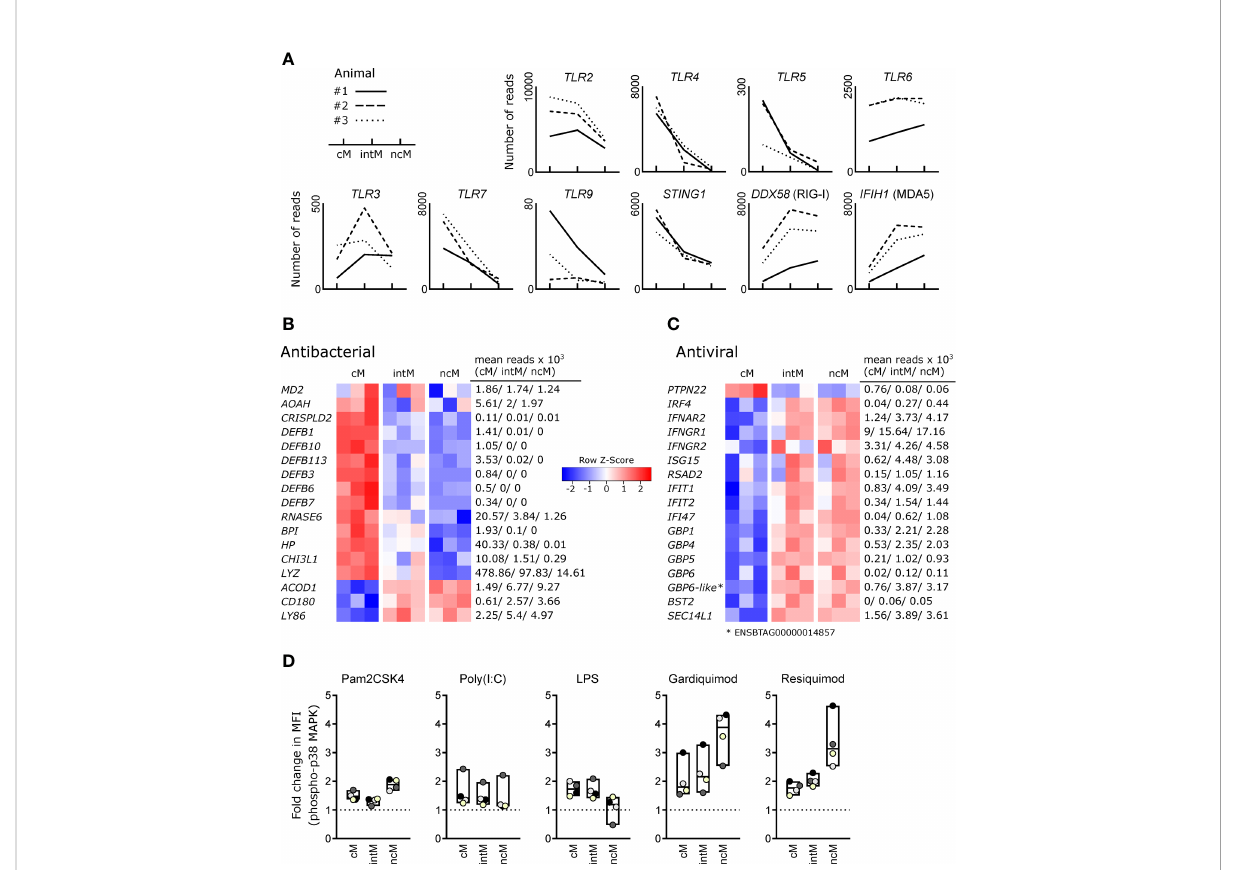
FIGURE 3 Antimicrobial gene expression and TLR responsiveness. Illumina sequencing was performed on RNA isolated from sorted monocyte subsets (cM, intM, ncM) of three animals. (A) Gene expression for pattern-recognition receptors. Graphs show the number of reads across monocyte subsets for selected genes with individual animals indicated by solid (#1), dashed (#2) and dotted (#3) lines. (B, C) Heatmaps show row z-scores calculated from log2-transformed normalized counts for genes associated with antibacterial (B) and antiviral (C) responses. Mean kilo reads for each subset and gene are given to the right of each heatmap. Genes were selected based on pairwise comparisons with DESeq2 (adjusted p- value < 0.05) and literature research. (D) Responsiveness of bovine monocyte subsets to TLR ligands. Defrosted bovine PBMC were depleted of CD3 + cells, stained for CD172a, CD14 and CD16, and stimulated with Pam2CSK4, Poly(I:C), LPS, Gardiquimod, or Resiquimod for 15 min, before being fi xed/permeabilized and stained with a fl uorochrome-conjugated monoclonal antibody against phosphorylated p38 MAPK. Incubation with PBS served as control. Graphs show the fold change in median fl uorescence intensity (MFI of stimulated sample divided by MFI of PBS control) of phospho-p38 MAPK staining for cM (CD14 high CD16 - ), intM (CD14 high CD16 high ) and ncM (CD14 -/dim CD16 high ). For each stimulation, data of four different animals (color-coded dots) is shown. Boxes indicate minimum, maximum and median values. Paired t-tests were performed on log-transformed MFI values of stimulated samples vs. PBS-incubated samples. Statistical analyses and exemplary fl ow cytometry plots are given in Supplementary File